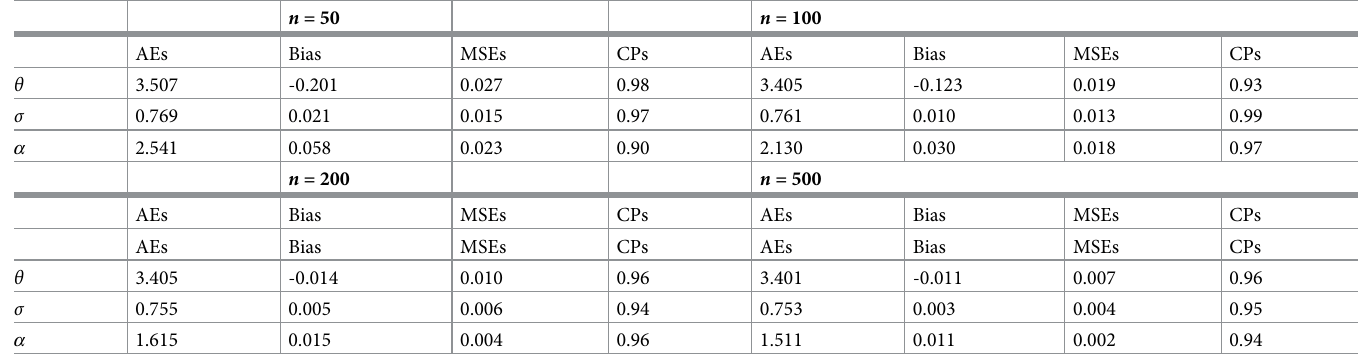
Table 6. AEs, Biases, MSEs and CPs for combination-IV.